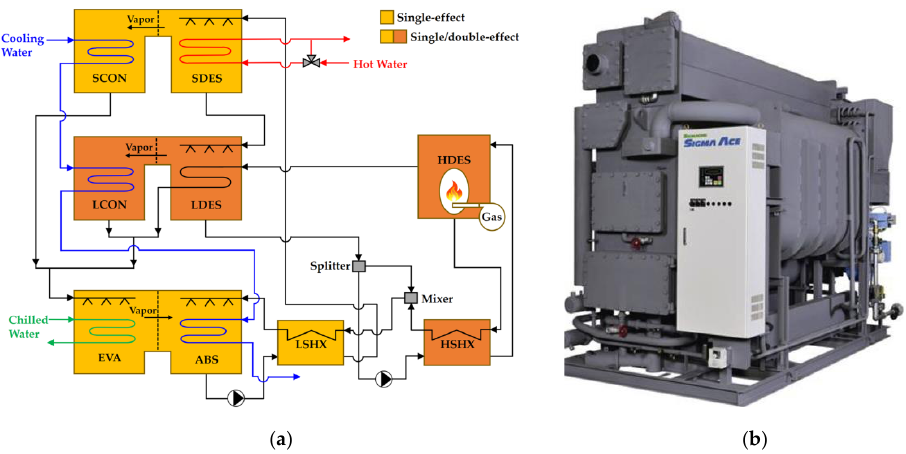
Figure 10. Solar-gas-fired single/double-effect absorption chiller from Kawasaki Thermal Engineering Co. Ltd. Adapted from Reference [41]. (a) Absorption cycle schematic; (b) Absorption chiller